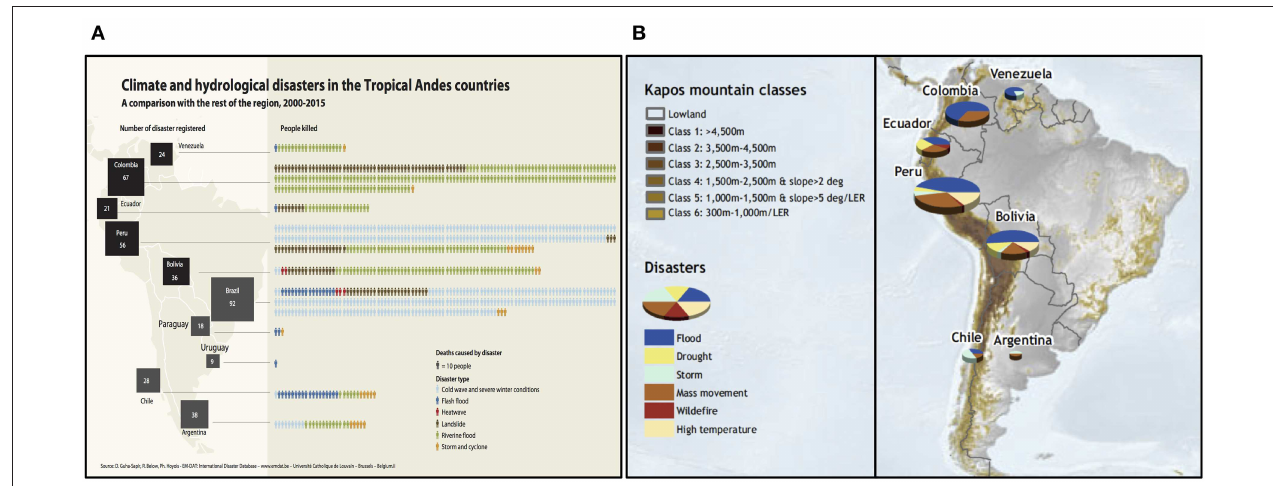
FIGURE 2 | (A) Climate and hydrological disasters in the Andean countries and human fatalities during the period spanning from 2000 to 2015. Source: Schoolmeester et al. (2016), from a figure made by GRID-Arendal and Cartografare il Presente/Riccardo Pravettoni (https://www.grida.no/resource). (B) Disasters along the Andes caused by storms, floods, mass movements, extreme temperatures, droughts and wild fires, based on EM-DAT ( Guha-Sapir et al., 2015). Cartography by Jürg Krauer, Centre for Development and Environment (CDE), University of Bern, Switzerland. Adapted from Stäubli et al. (2017) by permission from Springer, Climate Change Extreme Events and Disaster Risk Reduction , by S. Mal, R. B. Singh, and C. Huggel (eds.), Copyright,